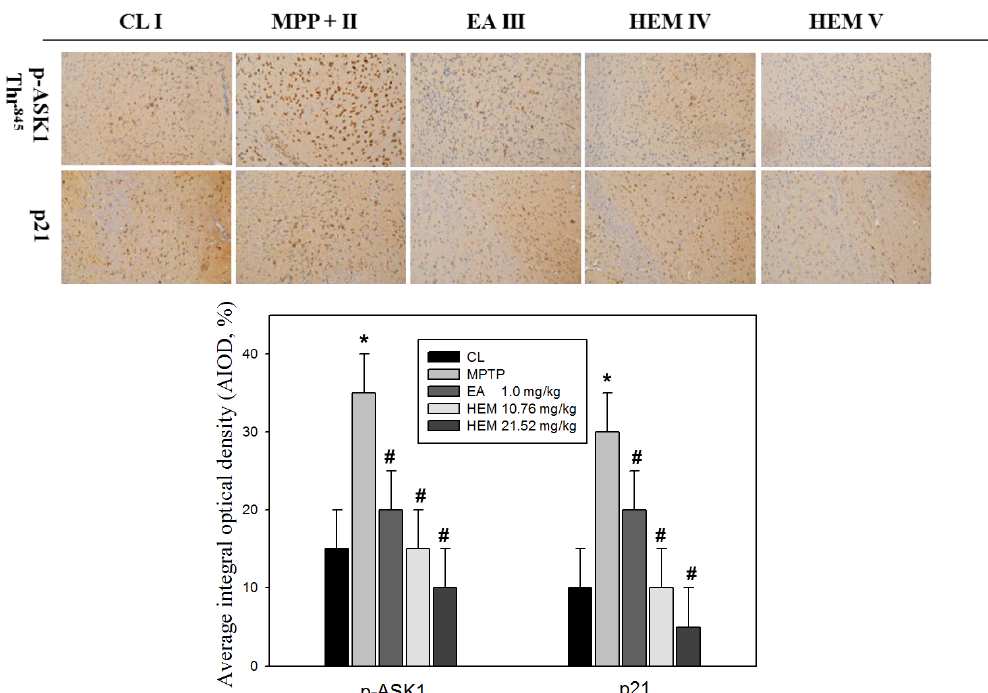
Figure 8. Post-treatment with erinacine A reduced the p-ASK1 and p21 expression in MPTP-treated animals. Representative IHC images of p-ASK1 and p21 in the brain region of the animals with MPP + or MPP + and erinacine A are as indicated. Quantified data of the average integral optical density are expressed as the mean ± SEM (* p < 0.01, as compared to the control group; # p < 0.01, as compared to the MPP + -treated group). Data are expressed as mean ± S.D. (n = 6/group).